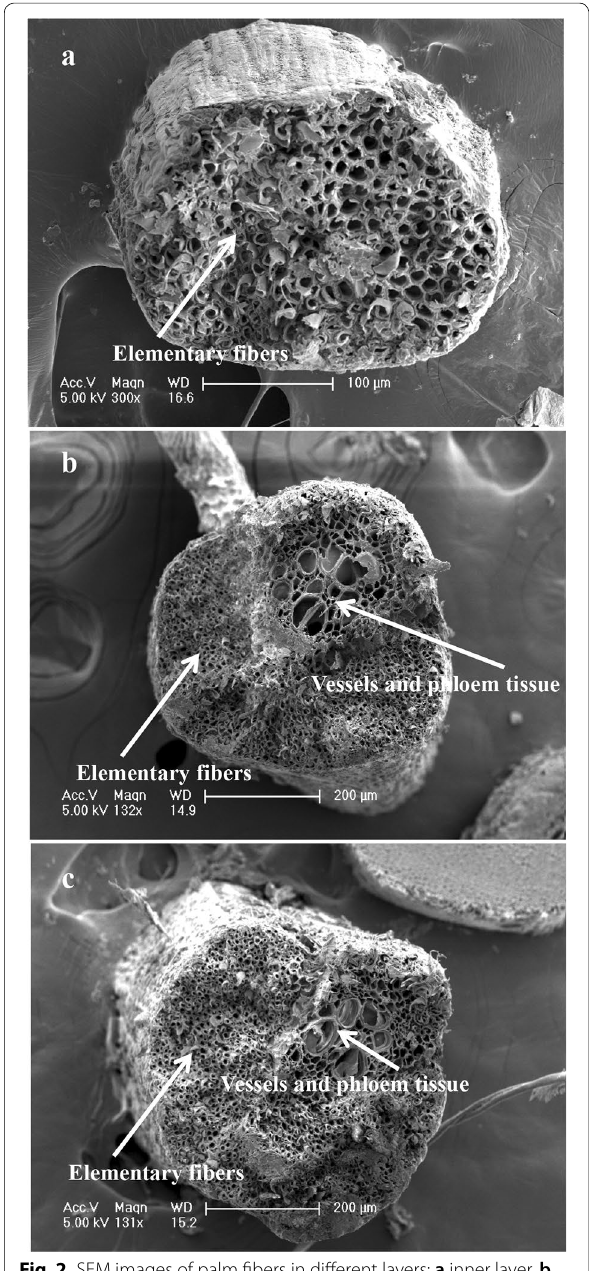
Fig. 2 SEM images of palm fibers in different layers: a inner layer, b middle layers, c outer